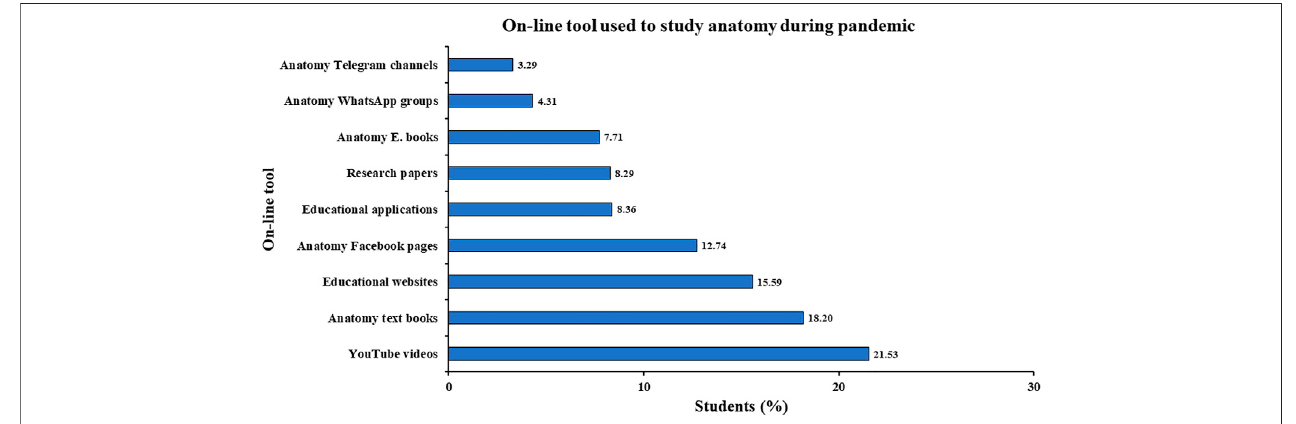
FIGURE 3 | A diagram showing the online tool used to study